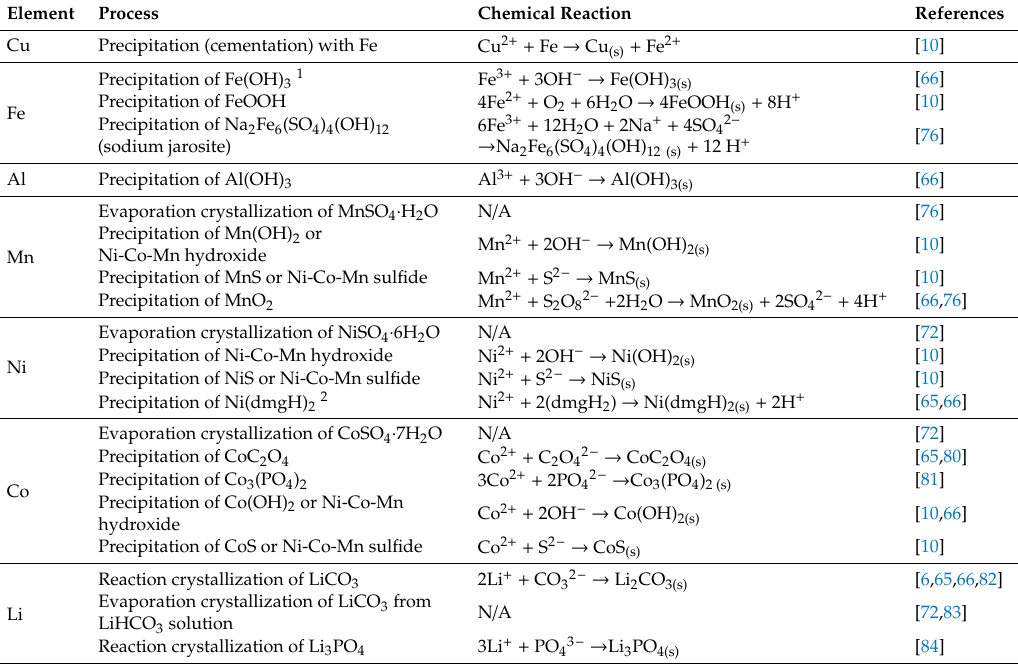
Table 6. Summary of precipitation and crystallization methods used in the recycling of Li-ion batteries.